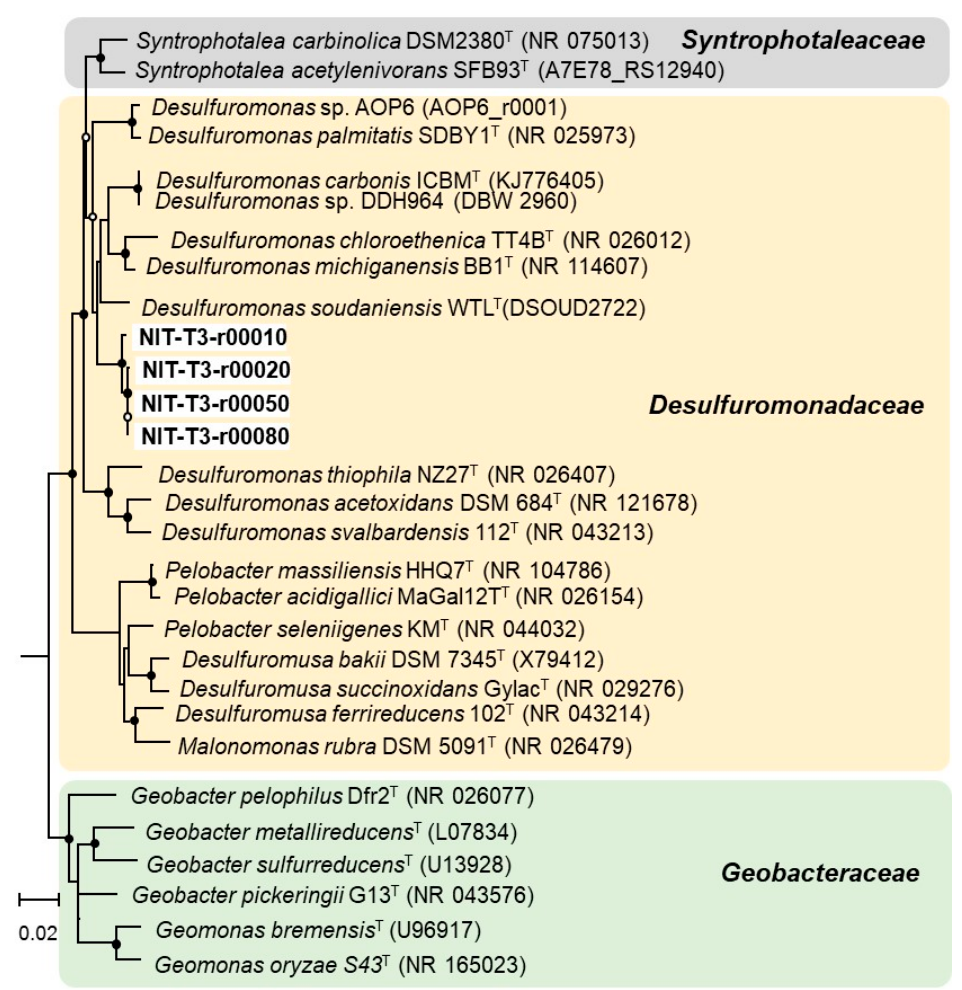
Figure 2. Phylogenetic tree generated using 16S rRNA gene sequences of members of Desulfuromonadales. Closed and open circles indicate bootstrap > 80% and 60%, respectively. GenBank accession numbers are stated in parentheses.